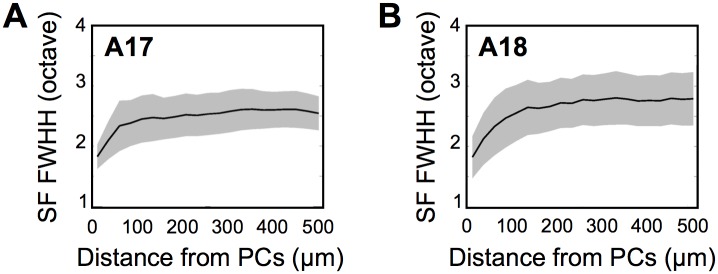
SF tuning width drops close from PCs.(A): Median FWHHSF (black curve) ± mad (gray) as a function of the distance from PCs in A17. Each point corresponds to a distance of 25 μm. (B): The same as (A) for A18.